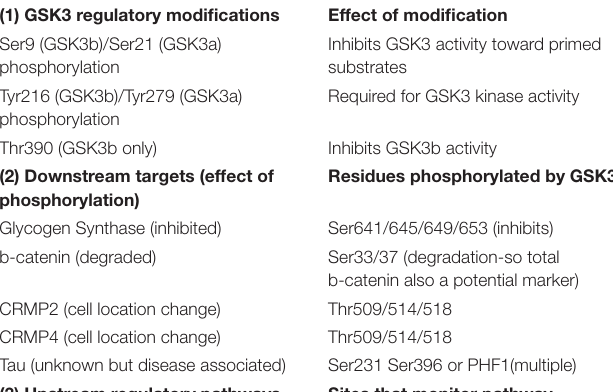
TABLE 1 | Potential molecular biomarkers of GSK3 activity, classified by the relationship to GSK3